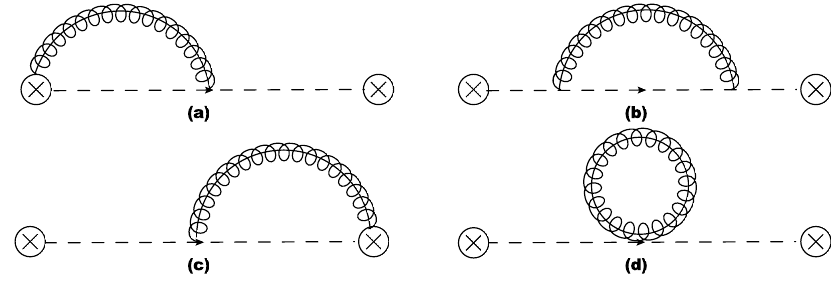
Figure 4 . Diagrams contributing to the one-loop jet